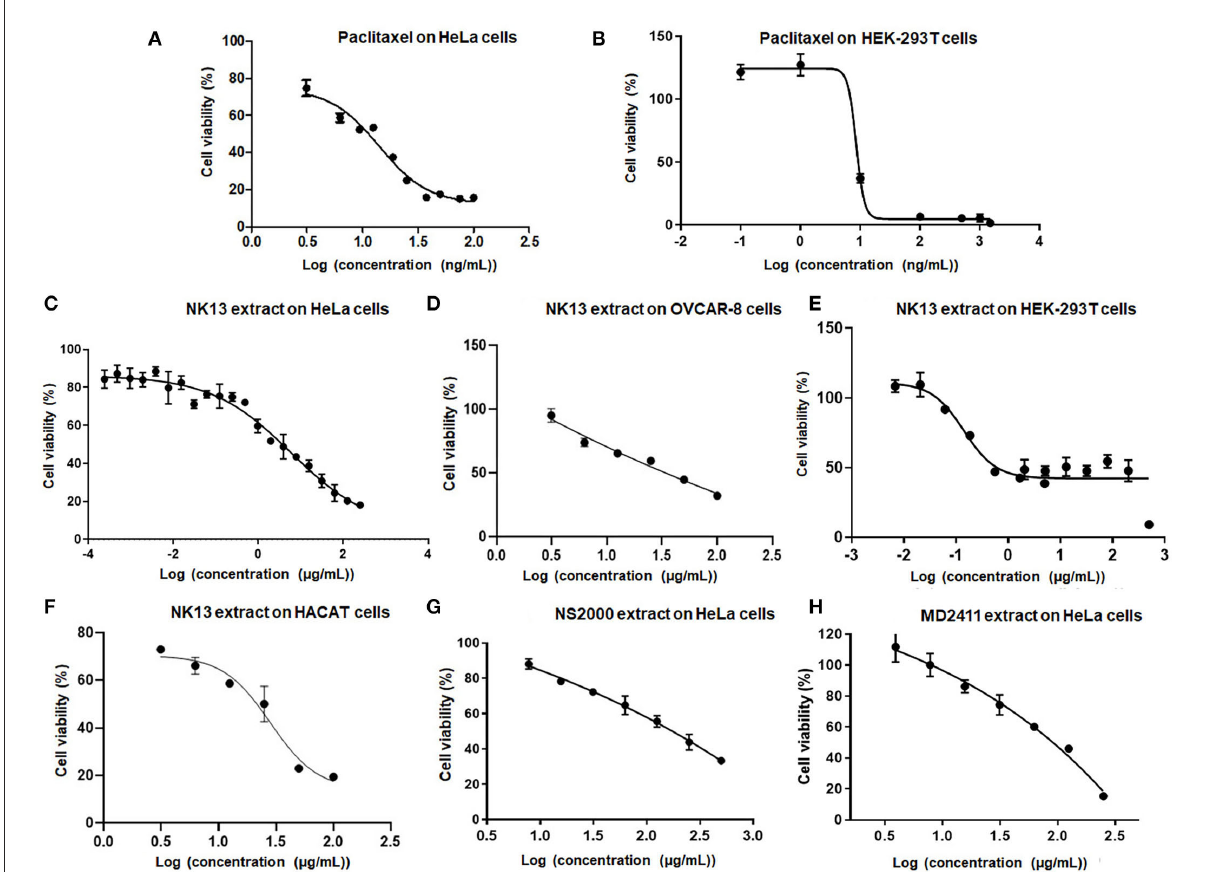
FIGURE4 Dose-respond curves of paclitaxel (A,B) and several positive extracts (C–H) to human cells. HeLa, Human cervical adenocarcinoma cells; OVCAR-8, Human ovarian carcinoma cells; HEK-293T, Human embryonic kidney cells; HaCaT, Human epidermal keratinocyte cells. Each kind of extract was incubated with cells for 48h, 4 parallels, n =